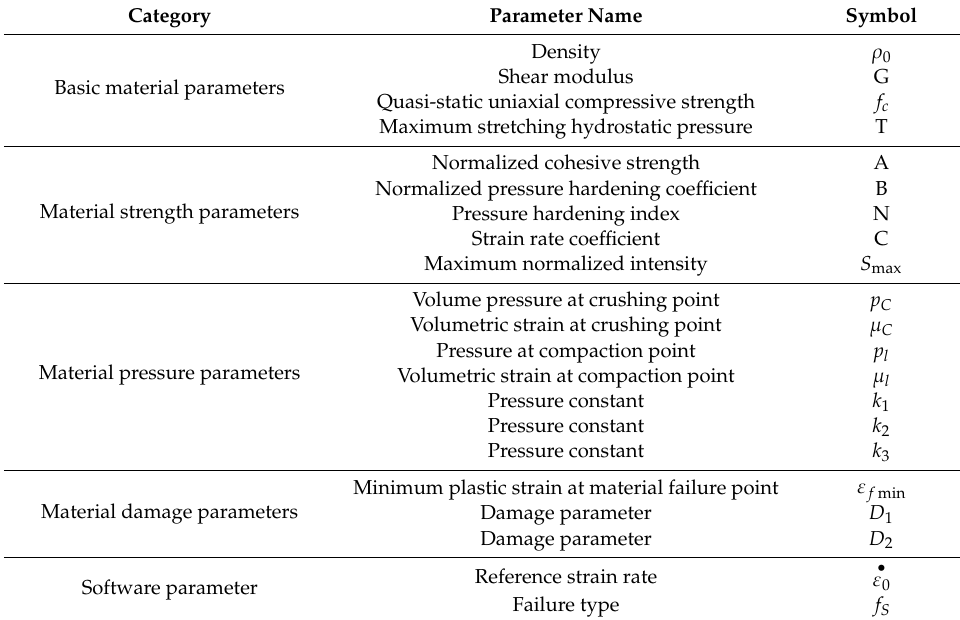
Table 1. Holmquist–Johnson–Cook (HJC) constitutive model material parameter